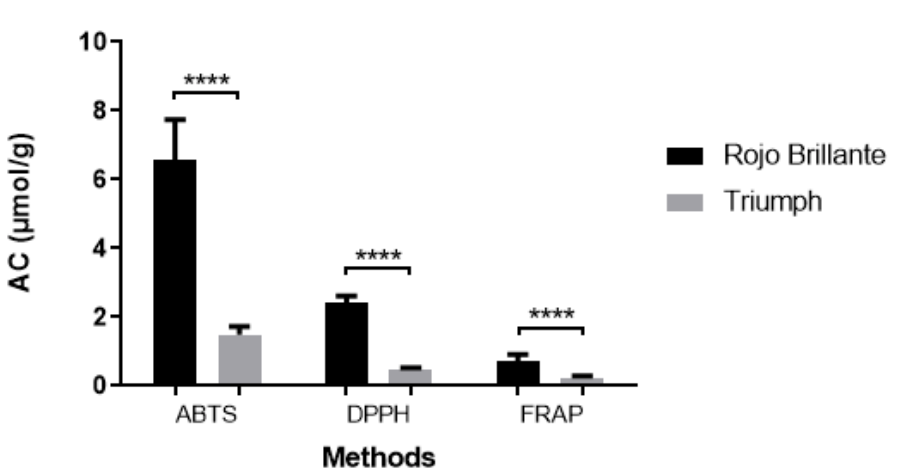
Figure 2. Evaluation of the antioxidant activity (AC) of the Rojo Brillante and Triumph varieties measured by ABTS, DPPH, and FRAP assay. **** Indicates p < 0.0001. The greatest ABTS · + scavenging capacity was detected in Rojo Brillante (6.572 µ mol